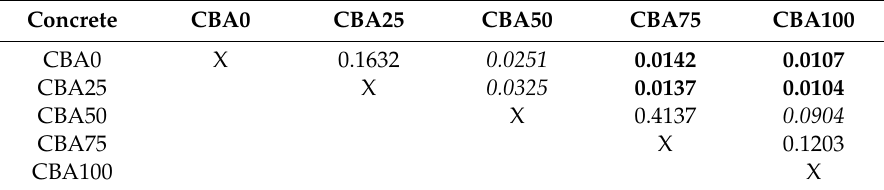
Table 2. The decrease in the 28-day compressive strength of concrete led to an increase in GWP, TE, WC, and FRS when the FU was normalized to the 28-day concrete compressive strength. The combination of the unidirectional responsible factors due to the transition from CBA0 to CBA100, the decreased 28-day compressive strength of the concrete, and the transportation of CBA from the coal-fired power plant to the local cement plant led to a significant increase in the impact of FRS. Table 4. p -values ( p ) of the paired di ff erences in the life-cycle assessment (LCA) production stage of 1 m 3 of concrete normalized according to the 28-day concrete compressive strength for the five concrete alternatives where sand was replaced with coal bottom ash (CBA). The concrete mixtures were designed with fixed a slump range of 60–80 mm.